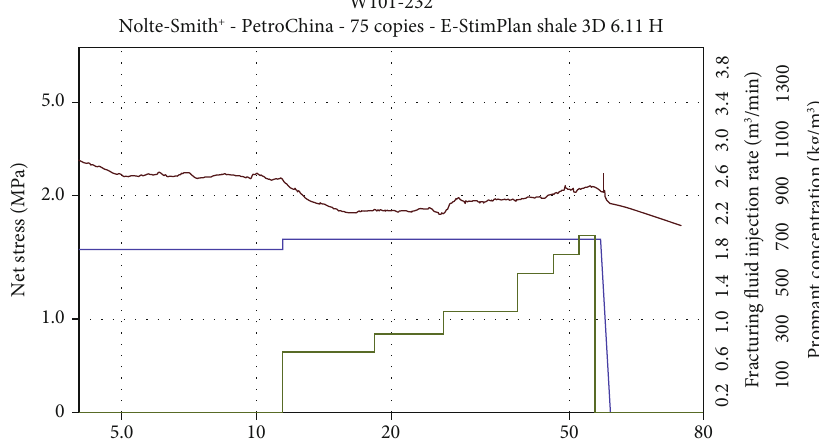
Figure 8: Nolte-Smith curve of fi xed-plane perforation fracturing in well